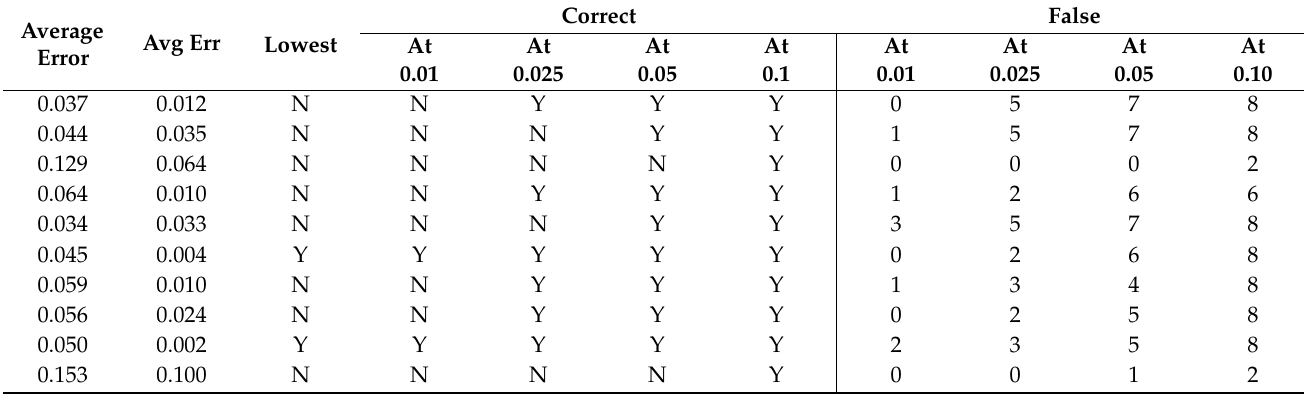
Table A13. Set 1, trials 1–10 summary data (single 0.5 PR